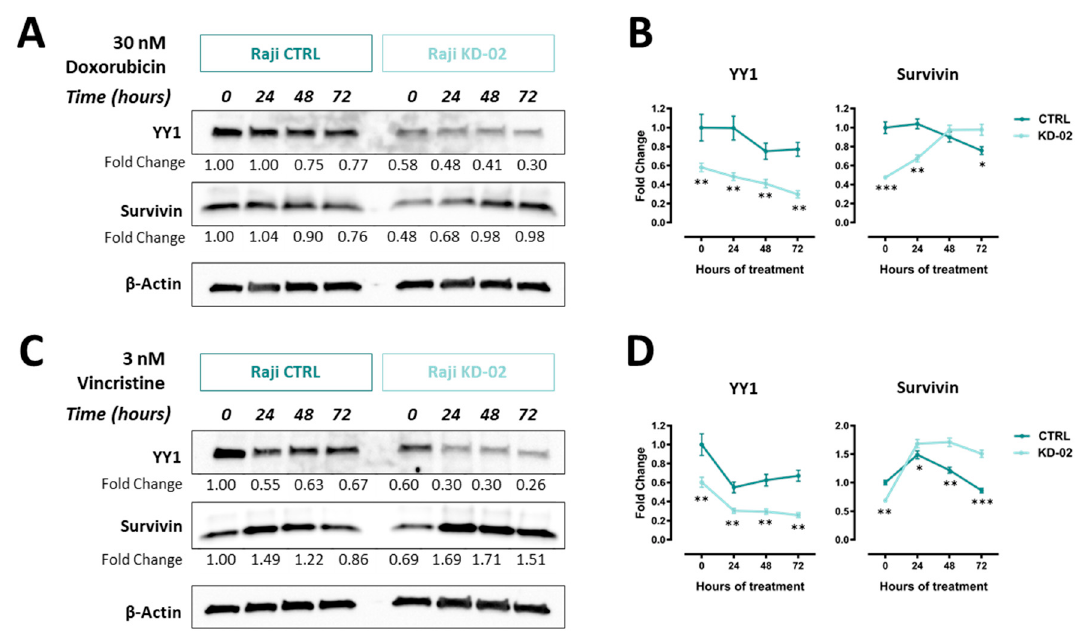
Figure 7. A. Western blot analysis of Raji cells non-silenced (CTRL) and silenced for YY1 (KD-02), treated with 30 nM doxorubicin, from 0 to 72 hours. Signal detected for YY1 protein (band at 60 KDa), survivin (band at 17 KDa) and β -actin protein (used as normalization control, band at 42KDa). B. Densitometry analysis for YY1 and survivin from the immunoblot reported in A, data expressed as fold change of the normalized signals, referred to the 0 hours CTRL value. C. Western blot analysis of Raji cells non-silenced (CTRL) and silenced for YY1 (KD-02), treated with 3 nM vincristine, from 0 to 72 hours. Signals detected for YY1, survivin and β -actin proteins. D. Densitometry analysis for YY1 and survivin from the immunoblot reported in C, data expressed as fold change of the normalized signals, referred to the 0 hours CTRL value. The results reported in B and D are presented as Mean ± SD and the comparison between the values obtained in CTRL vs. KD-02 protein samples was performed using the two-tailed unpaired t-test with Holm-Sidak correction for multiple comparisons (* P < 0.05; ** P < 0.01; *** P < 0.001).